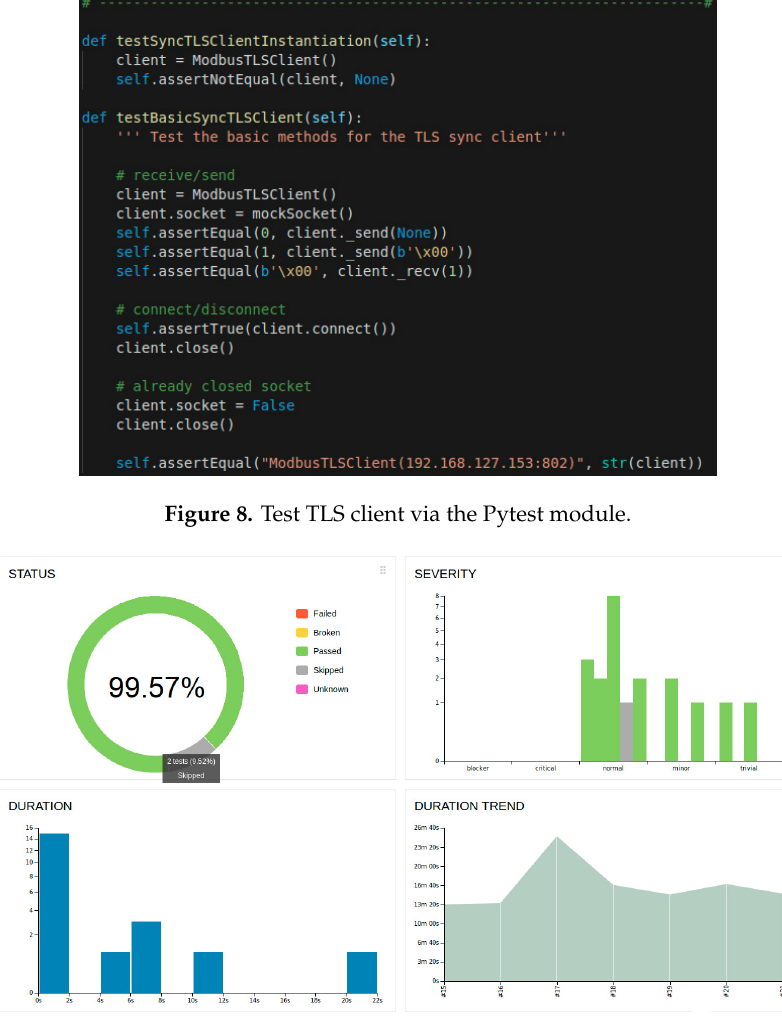
Figure 9. Report sample generated through Allure.